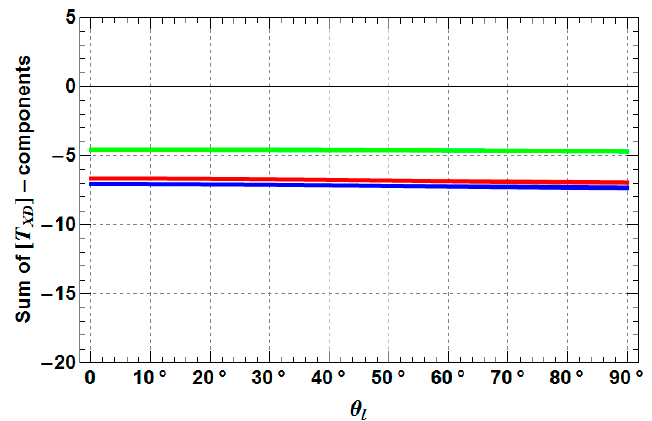
Figure 16. Sensitivity of coherency matrix combination T XD22 + T XD33 (blue) (dB) with roughness angle